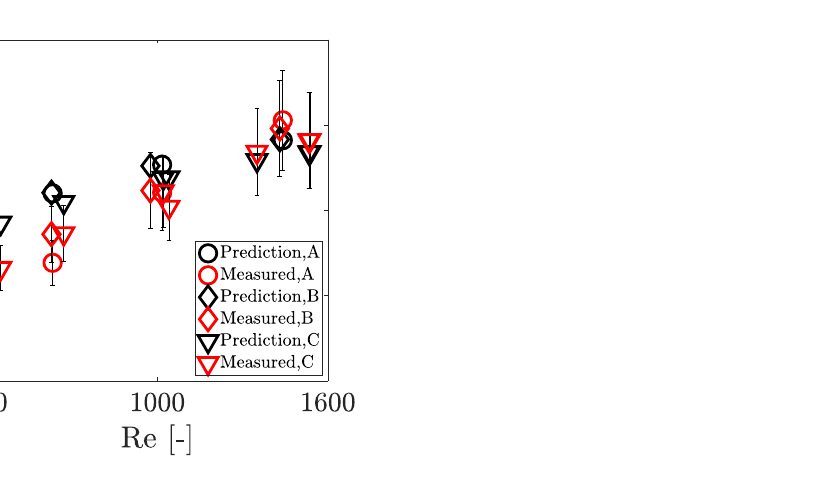
Figure 5. Comparison between the predictions of Nu by Shah and London [29] for simultaneously developing laminar flow and the experimental value measured in single-phase tests, having an mean absolute percent error of